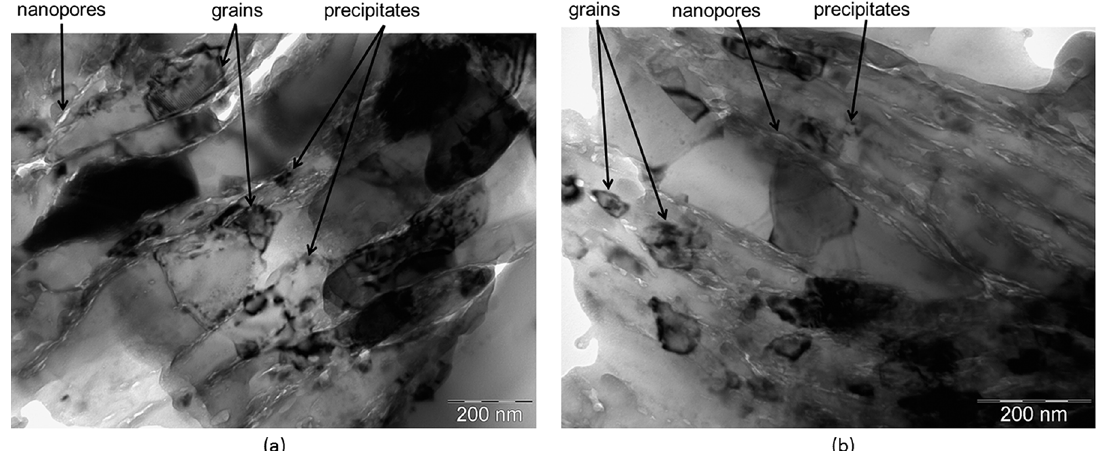
Figure 9. TEM images showing the microstructure of cryomilled sample degassed for 20 h at (a) 250 °C and (b) 350 °C and then sintered.